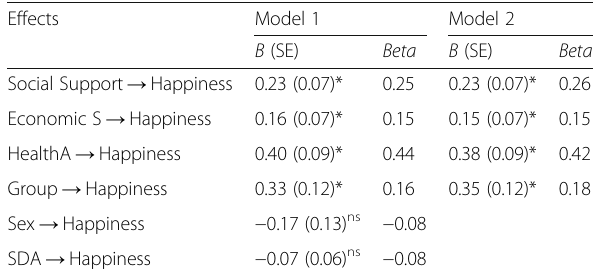
Table 2 Structural equation models with fixed effects examining predictors of happiness